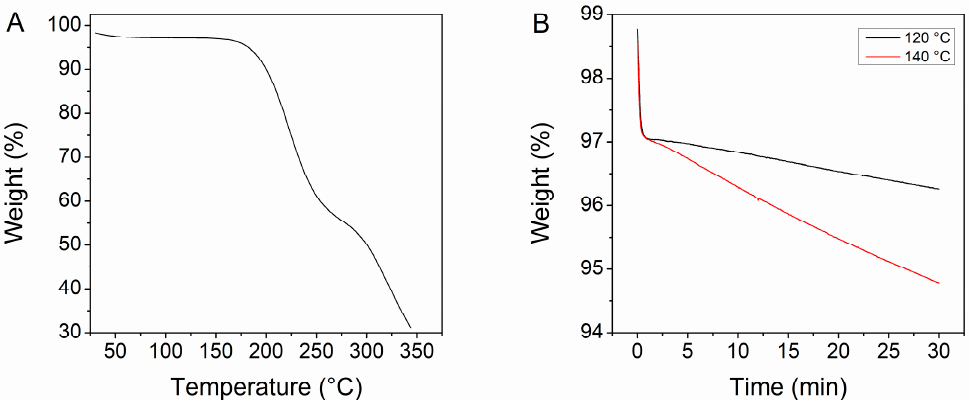
Figure 2. Thermogravimetric analysis of neat PVAP, ( A ) temperature gradient from 25 to 350 °C, ( B ) isothermal at 120 and 140 °C.